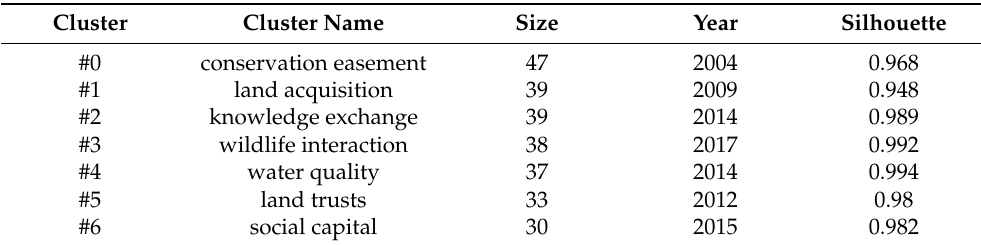
Table 2. Specific information of